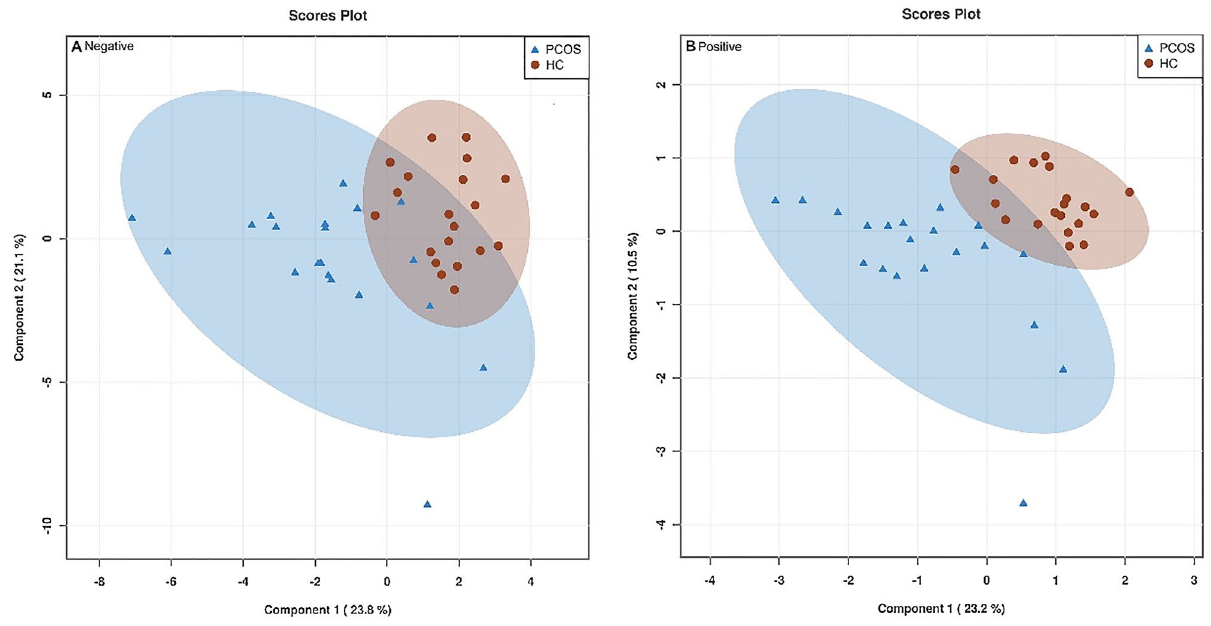
Figure 1. The PLS-DA plot of serum metabolomics in PCOS patients (blue triangles) and healthy controls (red circles). ESI(−), R2Y = 0.627, Q2 = 0.421 ( A ); ESI(+), R2Y = 0.761, Q2 = 0.580 ( B ). PCOS, n = 20, Healthy controls, n = 20.